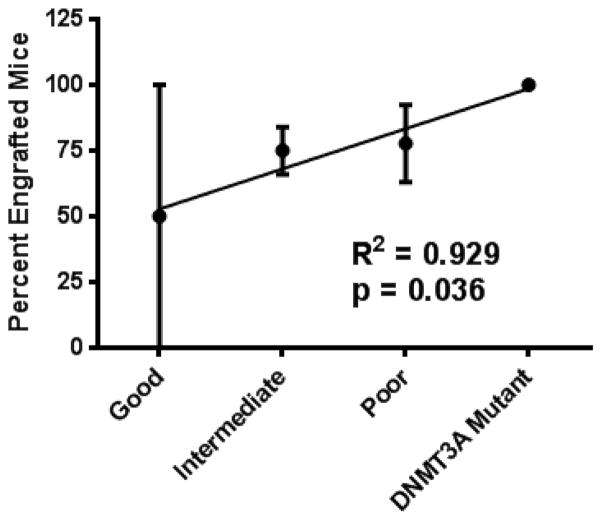
DNMT3A mutation predicts for enhanced engraftment in NSG mice. The integrated genetic risk profile, or DNMT3A mutation, was used to rank cases for linear regression analysis (1=good, 2=intermediate, 3=poor, 4=DNMT3A mutation).